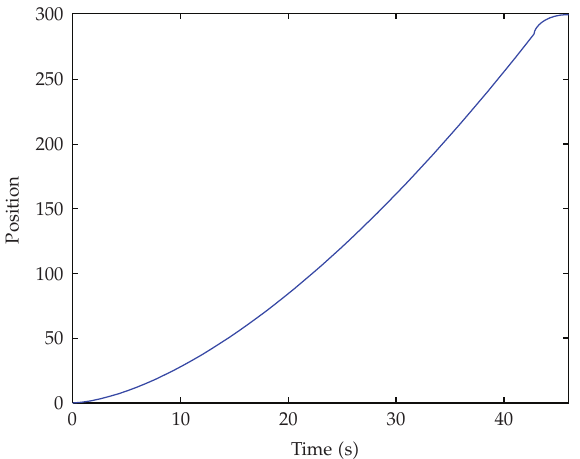
Figure 5: States x (cid:5) t (cid:6) as functions of time t for the Bang-Bang control problem for α (cid:7) 0 .